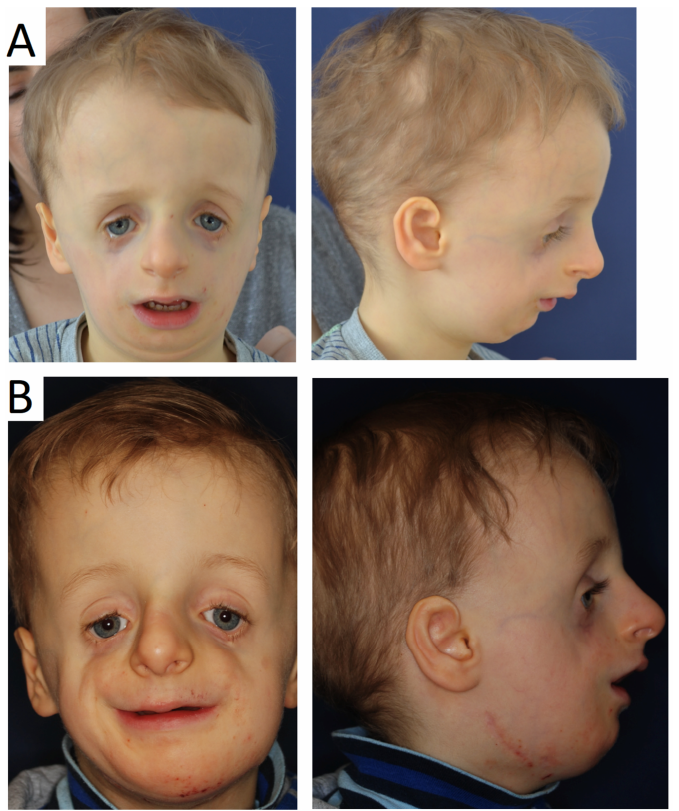
Figure 5. Patient at the age of 4 before ( A ) and after ( B ) mandibular distraction prior to further stages of treatment. Genes 2021 , 12 , x FOR PEER REVIEW